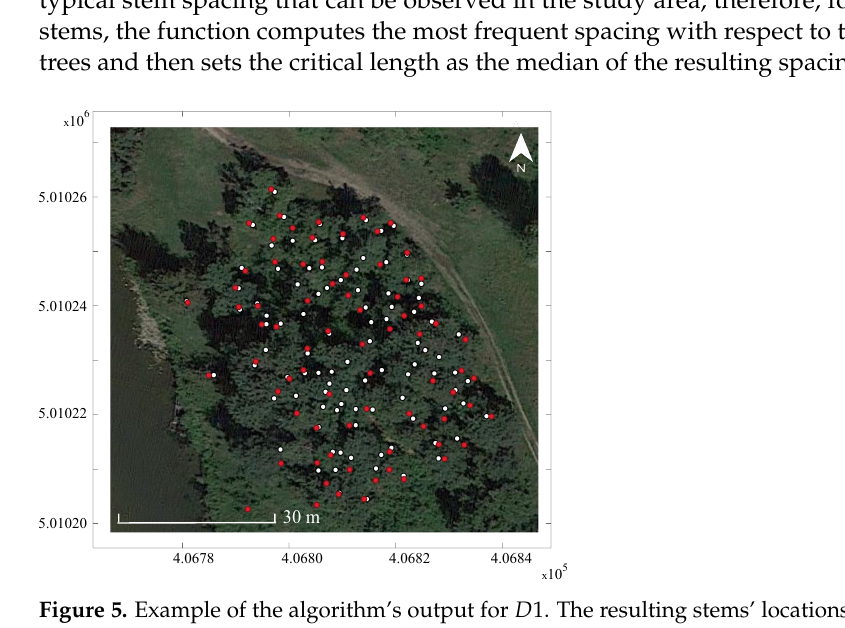
Figure 5. Example of the algorithm’s output for D 1. The resulting stems’ locations (red dots) can be imported in GIS and compared to field data (white dots).